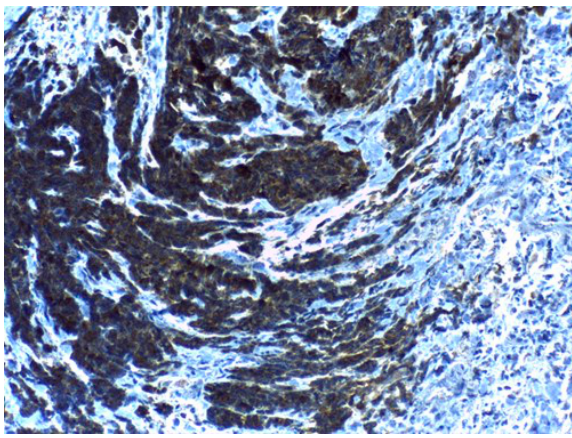
Figure 4. Strong cytoplasmic staining for NSE antibody.